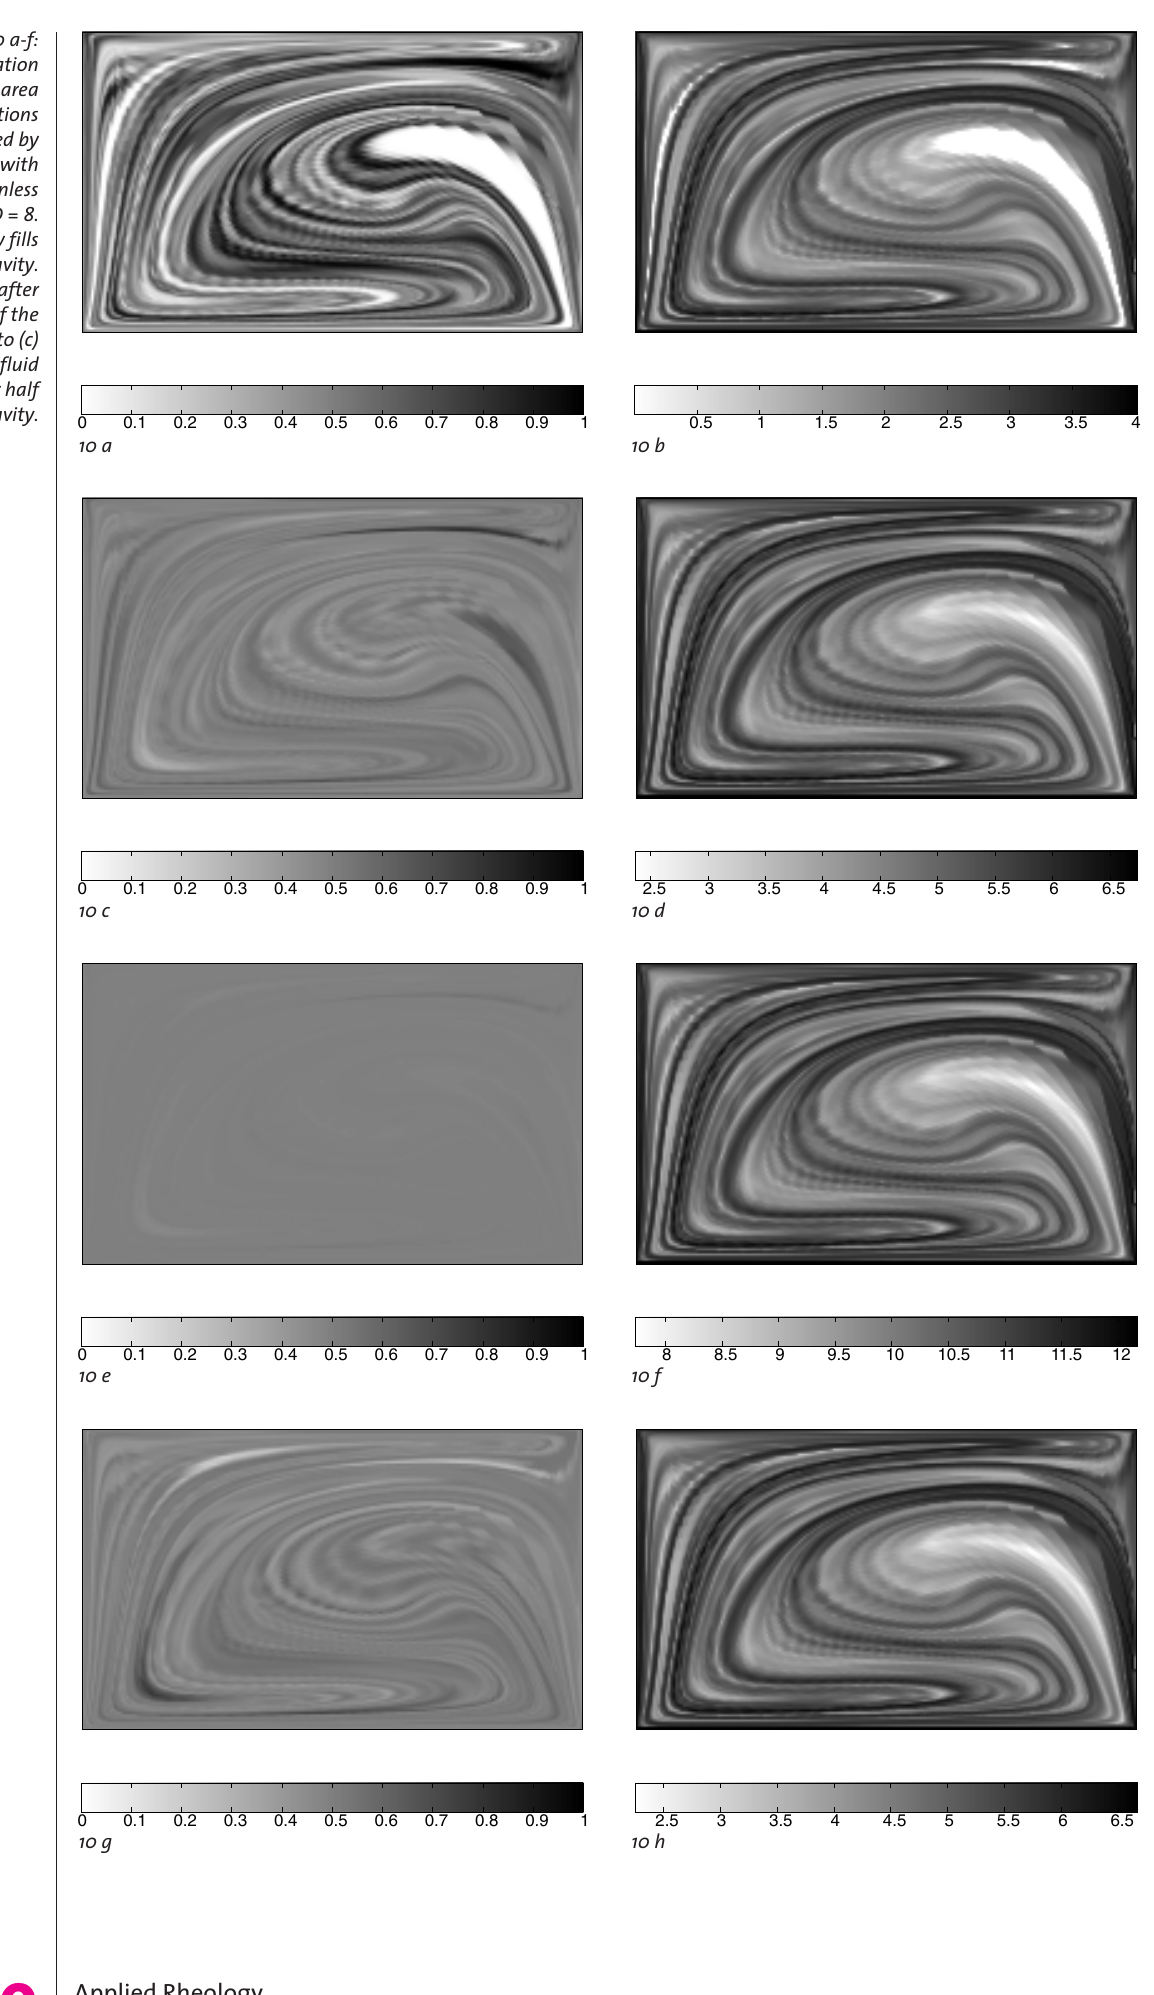
Figure 10 a-f: Evolution of concentration (left) and trace of the area tensor (right) distributions in the flow described by protocol TB-T-B with dimensionless displacement D =